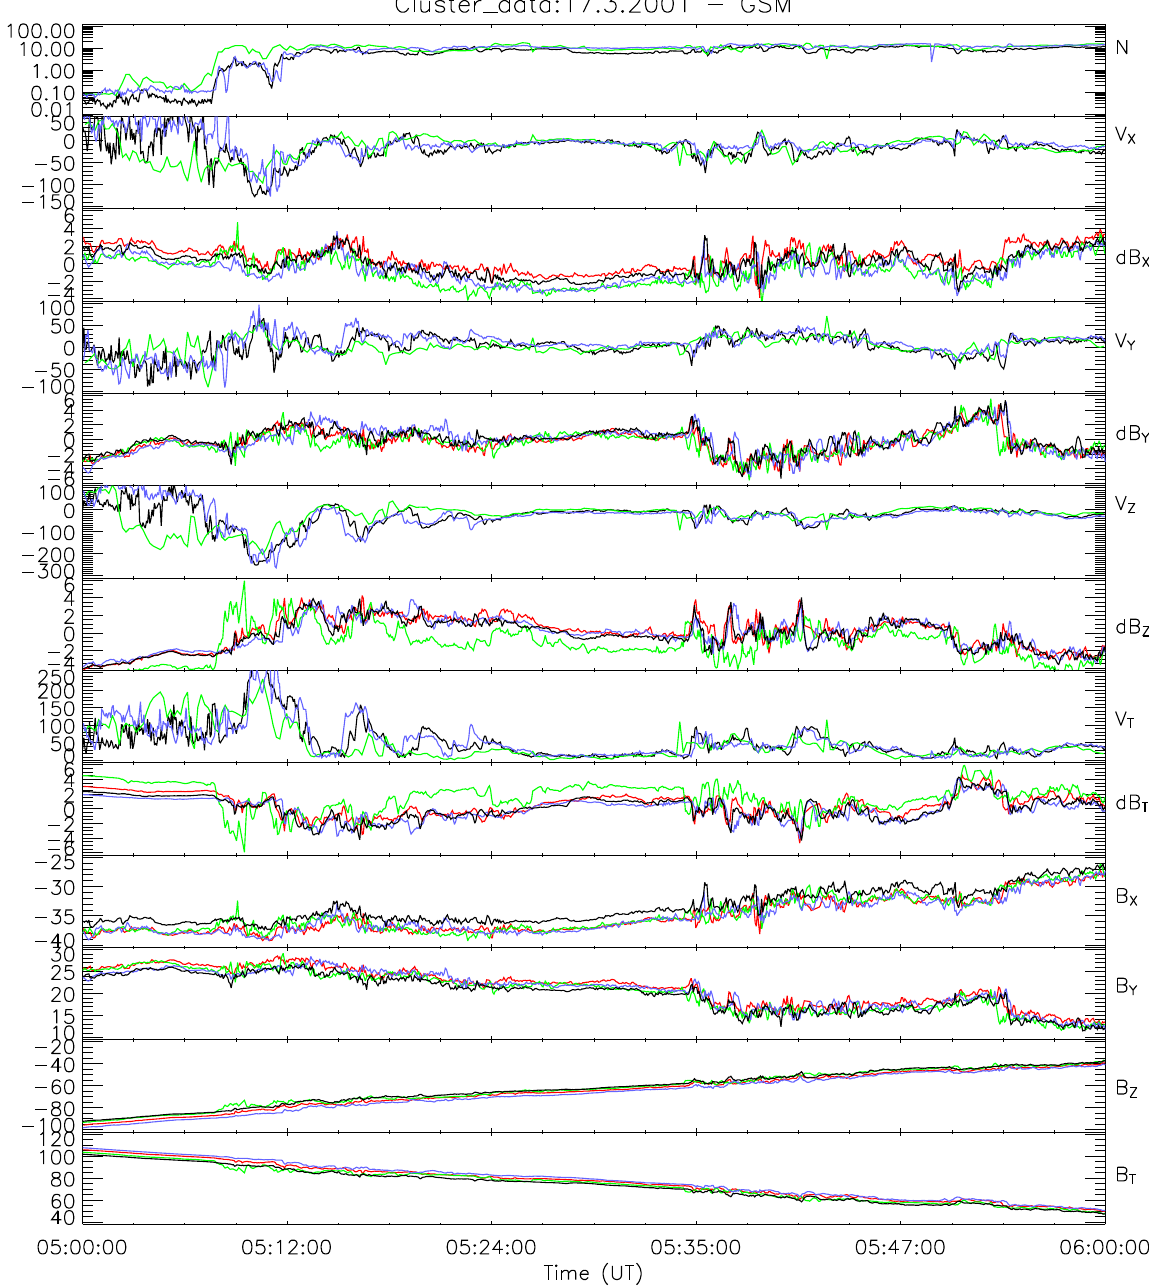
Fig. 5. Overview plot of the Cluster plasma and magnetic field observations on 17 March 2001 at 05:00–06:00UT. Panels are from top to bottom as follows: plasma density ( N ), x-component of the plasma velocity ( V x ), x-component of the de-trended magnetic field ( dB x ), V y , dB y , V z , dB z , total velocity ( V T ), de-trended total magnetic field component ( dB T ), B x , B y , B z , B tot